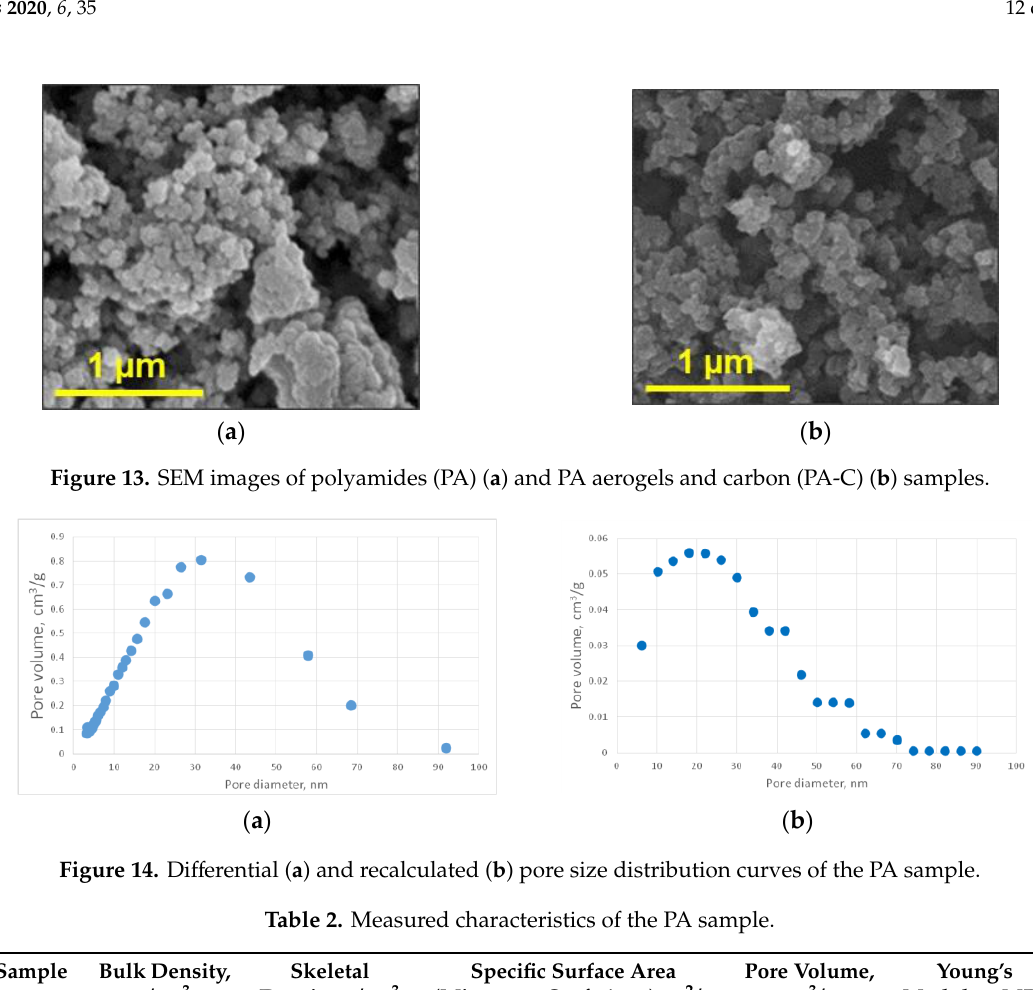
Figure 12. Structures of tris(4-isocyanatophenyl)methane (TIPM; Desmodur RE) ( a ) and pyromellitic acid (PMA) ( b ). Groups shown in green react according to Equation (2). Materials were characterized in terms of their skeletal densities using He pycnometry, bulk densities, BET surface areas and BJH pore size distribution using N 2 sorption porosimetry, and morphology using SEM. 4.2. Conversion of PA Aerogels to Carbon Aerogels (PA-C) Carbon (PA-C) aerogels were prepared from the pyrolysis of PA aerogels. Samples were prepared according to a procedure described in [21]. In brief, the PA aerogels prepared as described in Section 4.1 above were processed using an MTI GSL-1800X-KS60 tube furnace (Al 2 O 3 ceramic >99.9% pure, 54/60 mm inner/outer diameters, 300 mm heating zone). The temperature was raised to 800 °C at 2.5 o C min −1 under flowing Ar (150 mL min −1 ) for 5 h. PA-C aerogels were characterized in terms of their skeletal densities using He pycnometry, bulk densities, BET surface areas and BJH pore size distribution using N 2 sorption porosimetry, and morphology using SEM. 4.3. Aerogel Structure Modeling 4.3.1. Polyamide (PA) Aerogel Structure Modeling For this work, PA aerogels were synthesized from TIPM (Desmodur RE, Figure 12) and pyromellitic acid (PMA, Figure 12), as described in Section 4.1 above. The obtained structural characteristics and mechanical properties of produced PA aerogels, such as skeletal and bulk